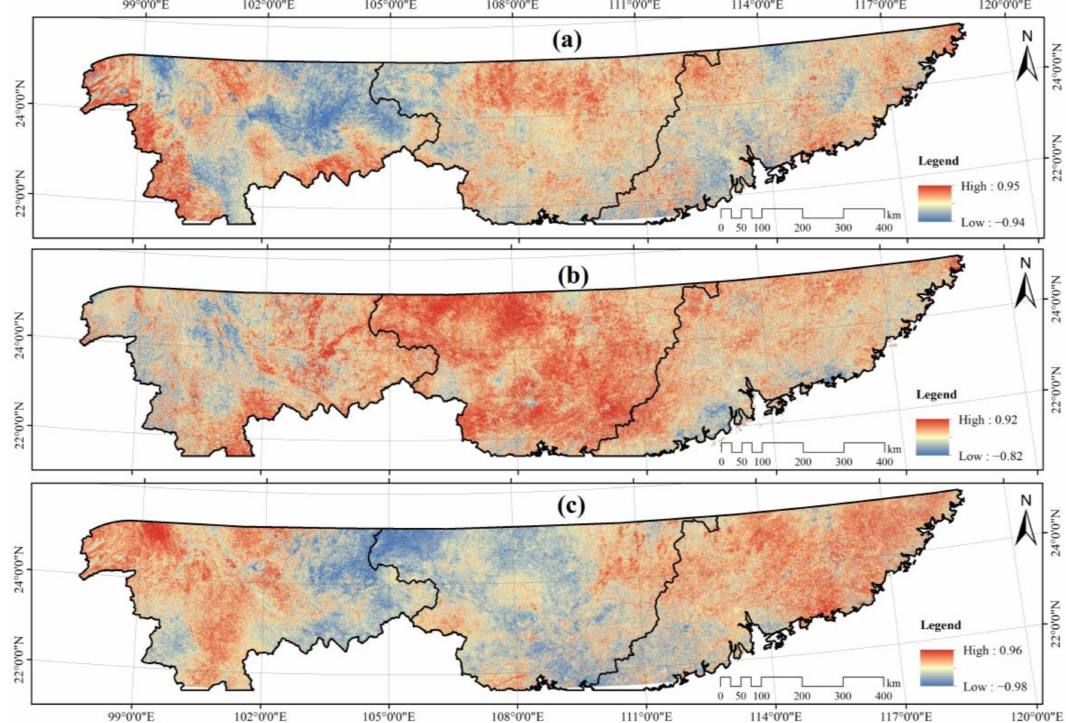
Figure 4. Partial correlations between NPP and ( a ) Tem, ( b ) Pre, and ( c ) SR.